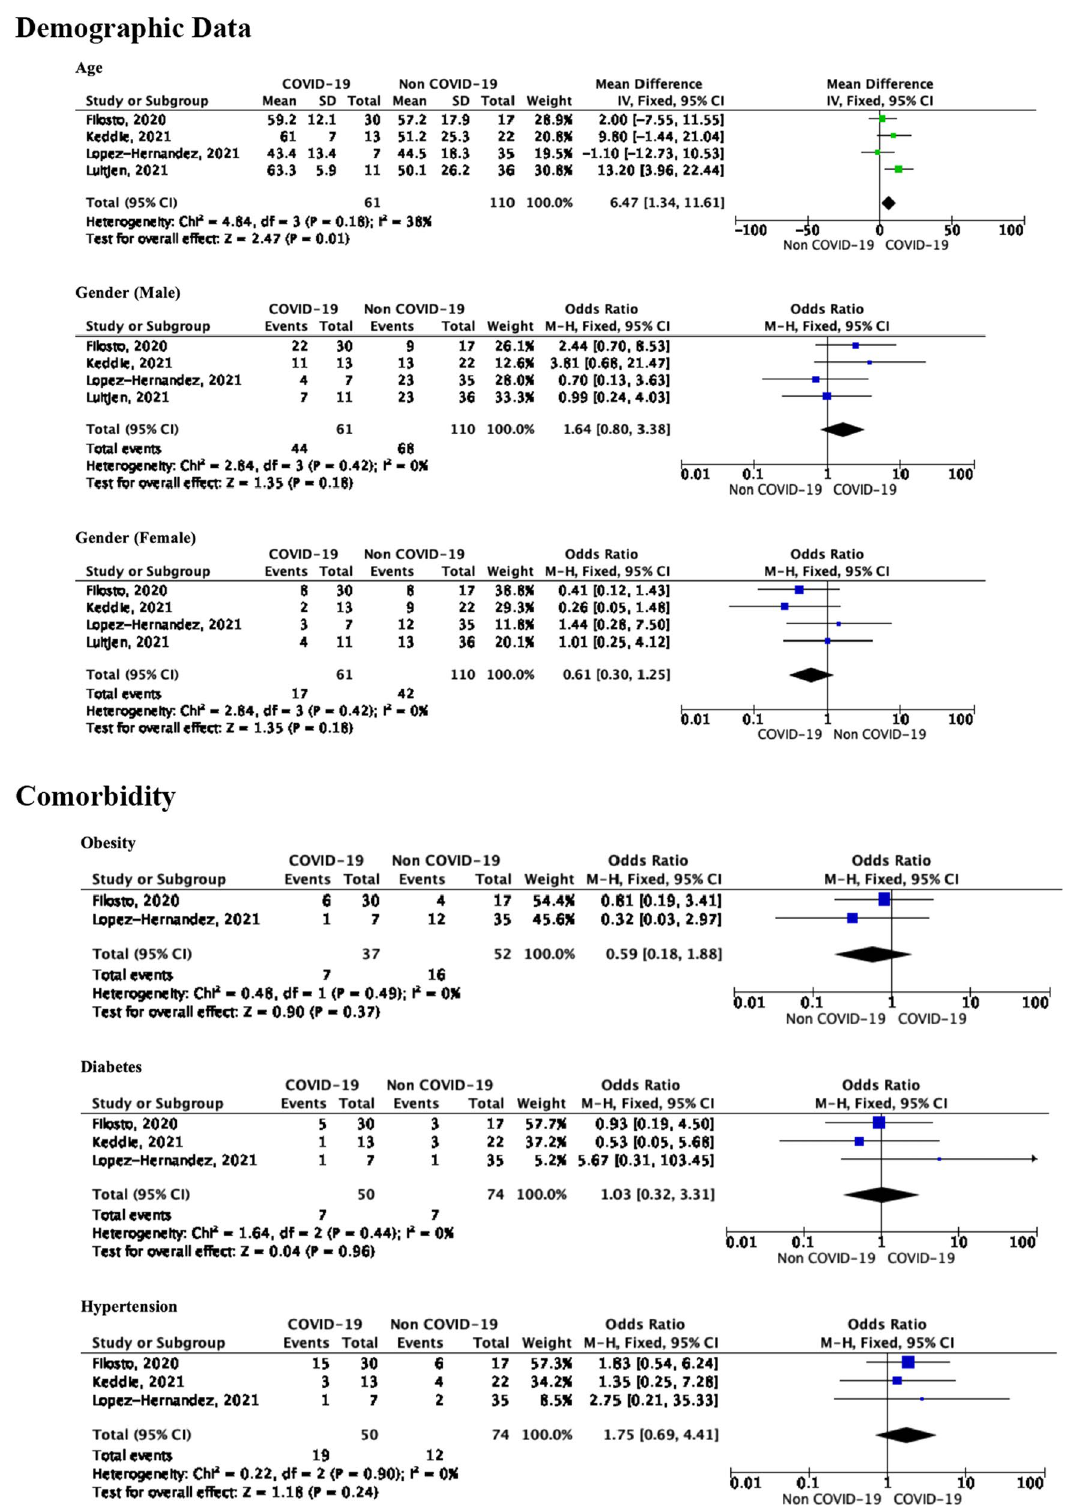
Appendix 2: Forest plot analysis of each variable between the GBS group with and without COVID‑19